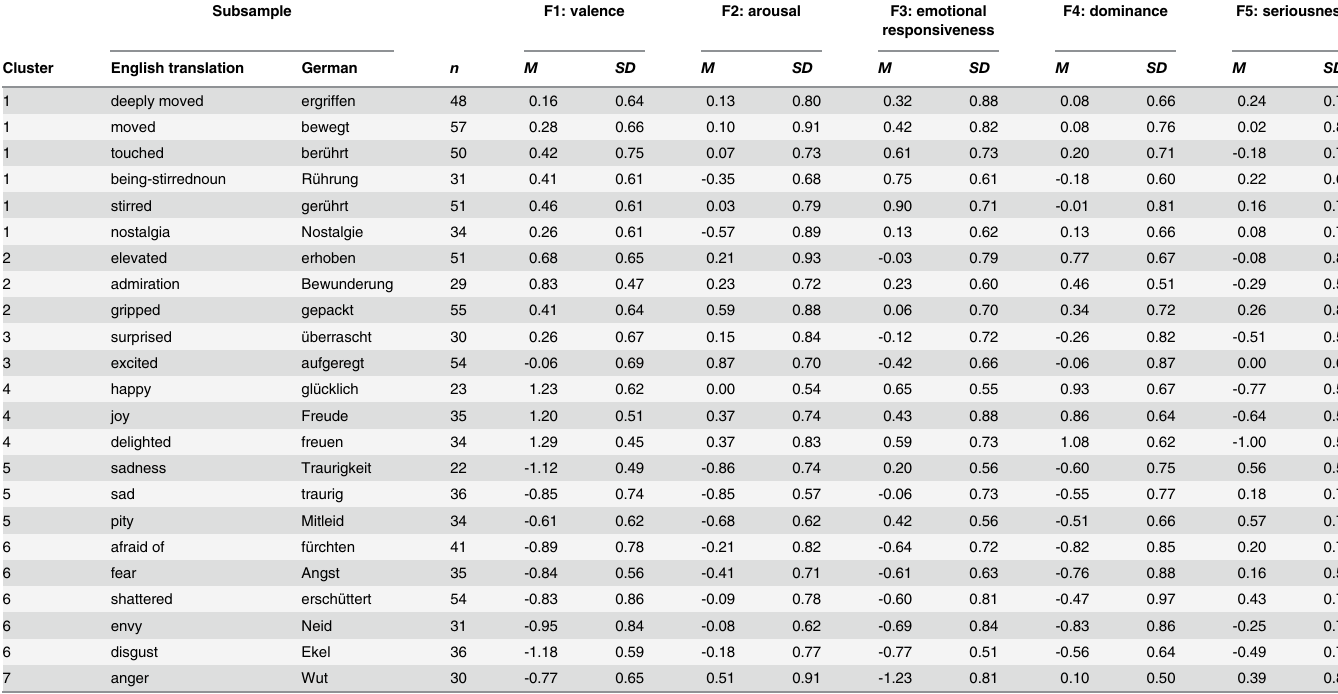
Table 3. Overview of the subsamples of Study 3 with the means of the factor scores for the five dimensions of the EFA for each emotion concept. Subsample F1: valence F2: arousal F3: emotional